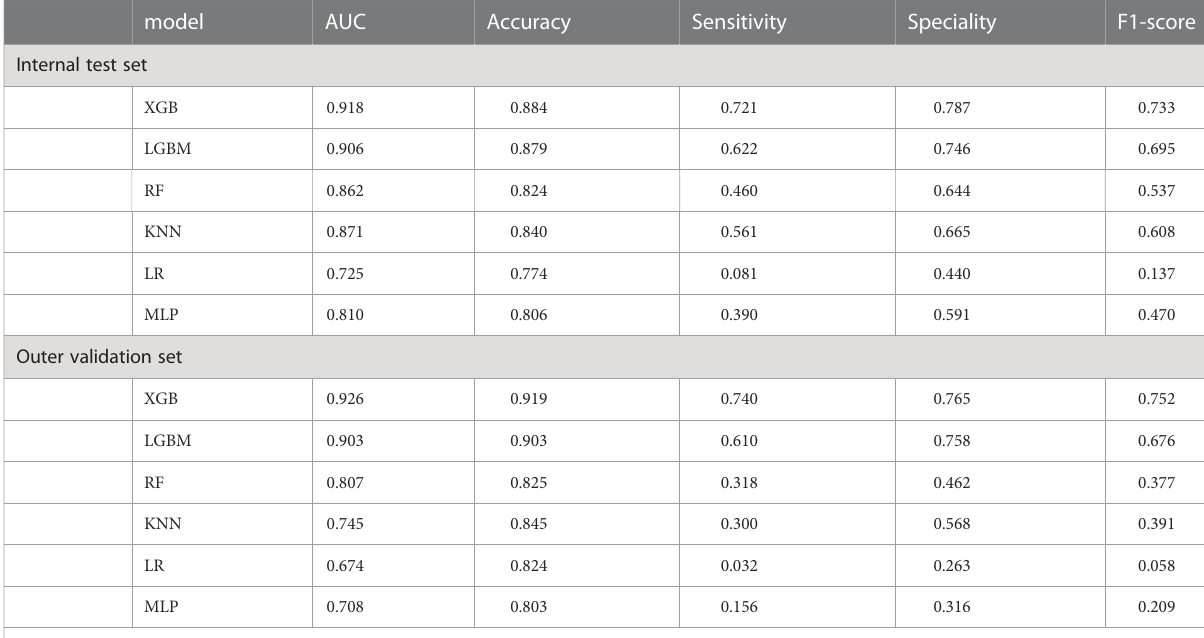
TABLE 3 Comparison prediction performances of different models for liver metastasis.